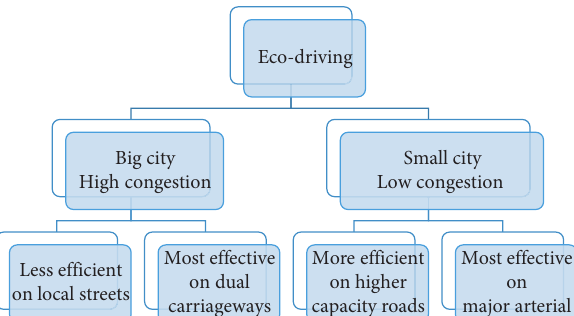
Figure 12: Eco-driving impacts in different types of